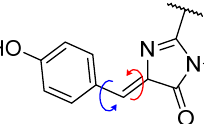
Figure 1. p -hydroxybenzylidene-imidazolidinone chromophore responsible for the emission of the GFP.